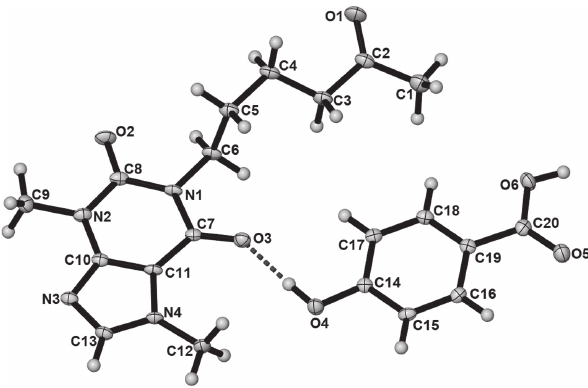
Table 2: Fractional atomic coordinates and isotropic or